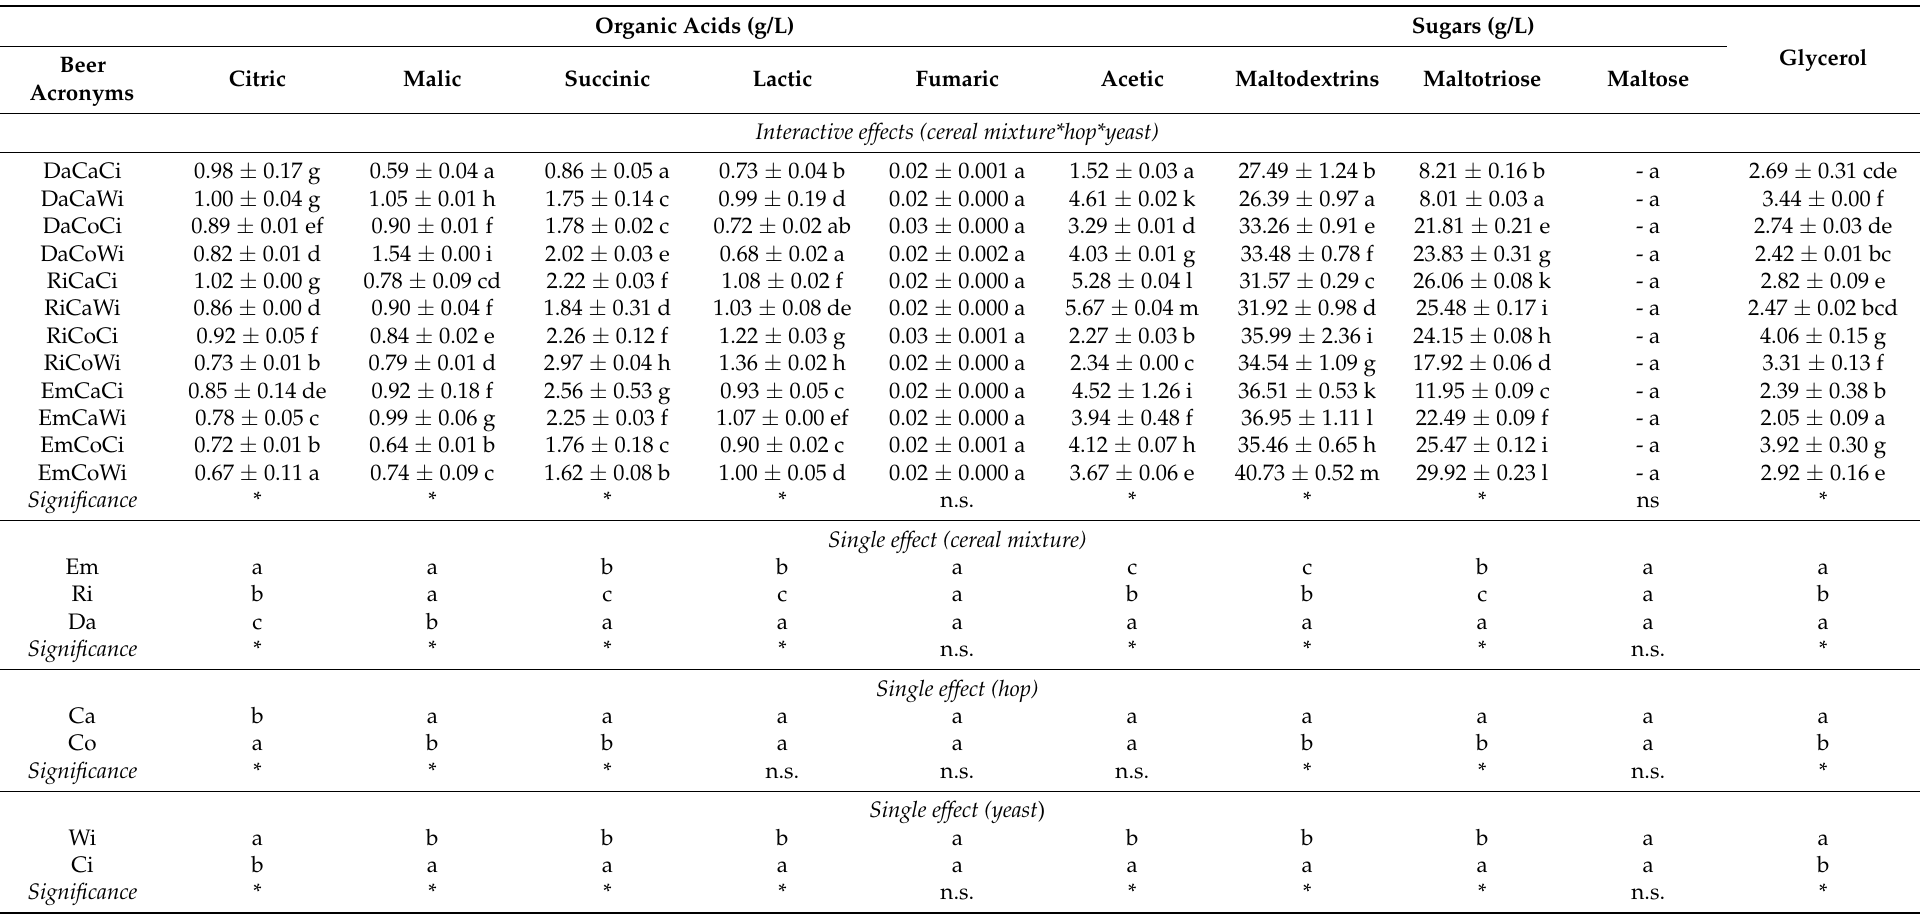
Table 4. Contents in organic acids, sugars, and glycerol of beer samples. Single and interactive effects of cereal mixtures, hops, and yeasts used in brewing. Organic Acids (g/L) Sugars